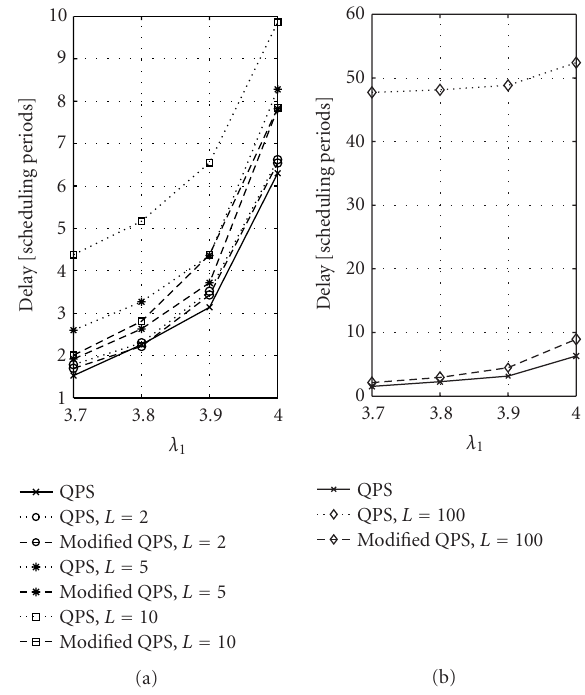
Figure 3: Comparison of performance of QPS, QPS with reduced use of QSI and modified